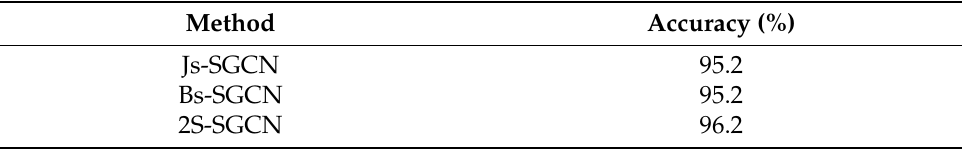
Table 4. Comparisons of validation accuracy with different input